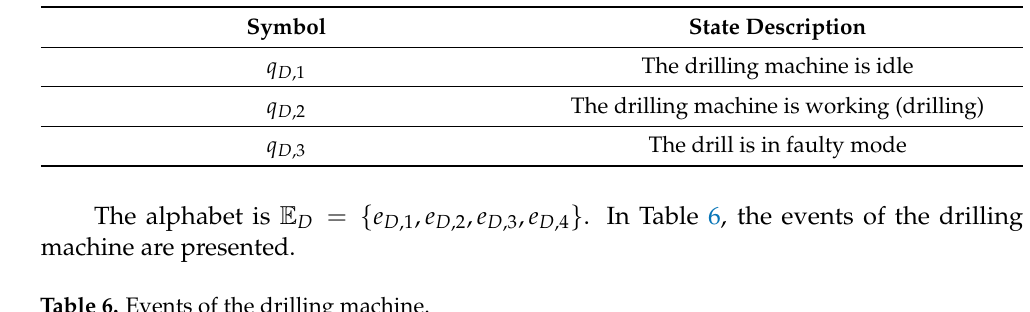
Table 6. Events of the drilling